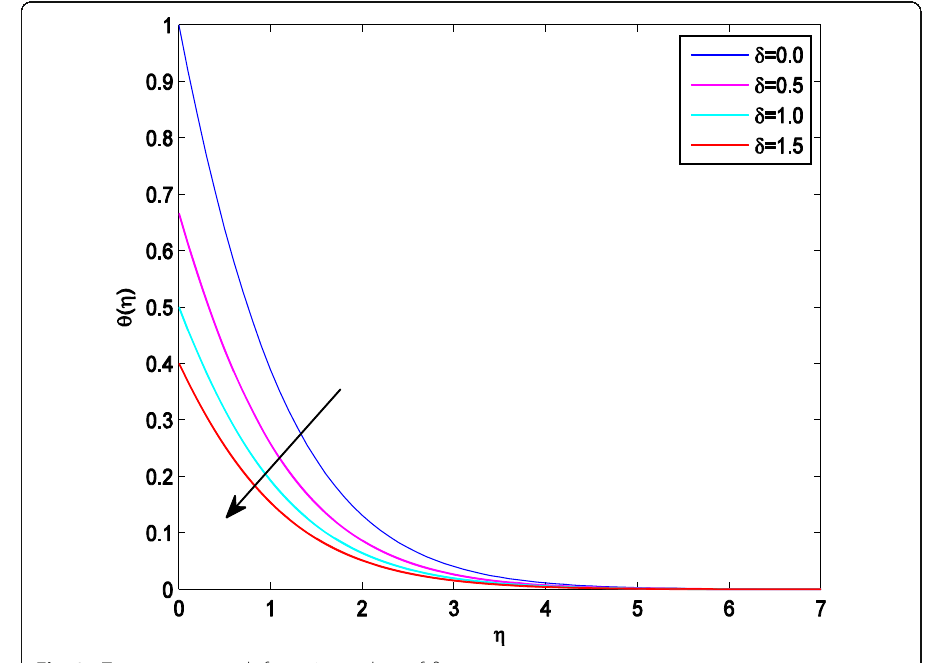
Fig. 24 Temperature graph for various values of